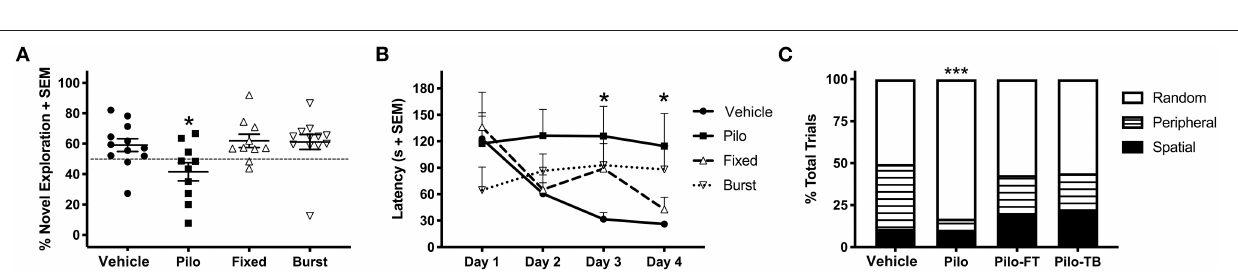
FIGURE 5 | Group differences on behavioral tasks. (A) On PPD 43–45, Pilo animals demonstrated significantly reduced preference for the novel object as compared to Vehicle. Fixed and Burst stimulation groups were no different than Vehicle. (B) Analysis of the Barnes maze on PPD 50–53 revealed that Pilo animals had a significantly elevated latency to the escape box as compared with Vehicle. Both stimulation groups had statistically similar latencies to the Vehicle group. (C) Pilo animals demonstrated significantly different search strategy utilization as compared with Vehicle. Both stimulation groups also had different strategy utilizations as compared to Vehicle. * p < 0.05, *** p <